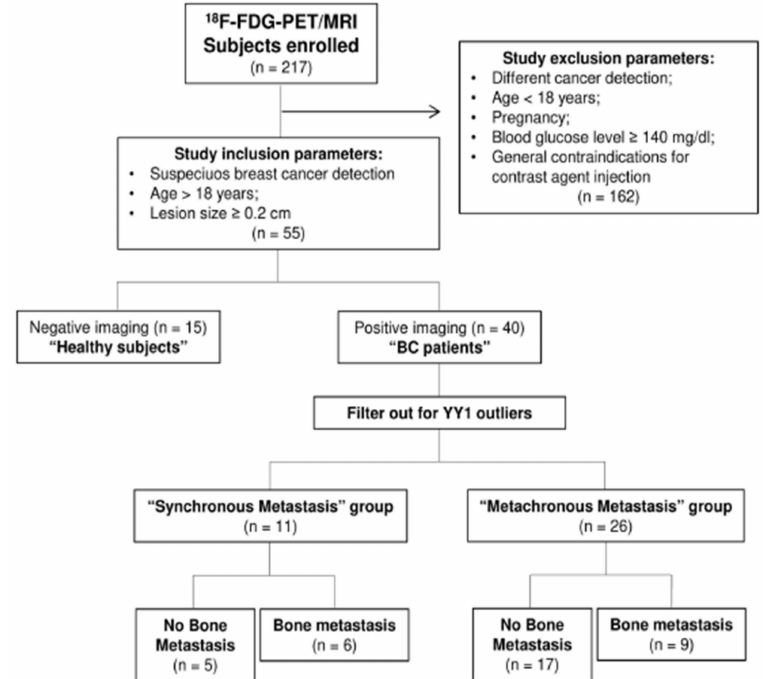
Figure 1. Eligible patients included in the study. Subject flow chart describing inclusion and exclusion criteria for the selection of the